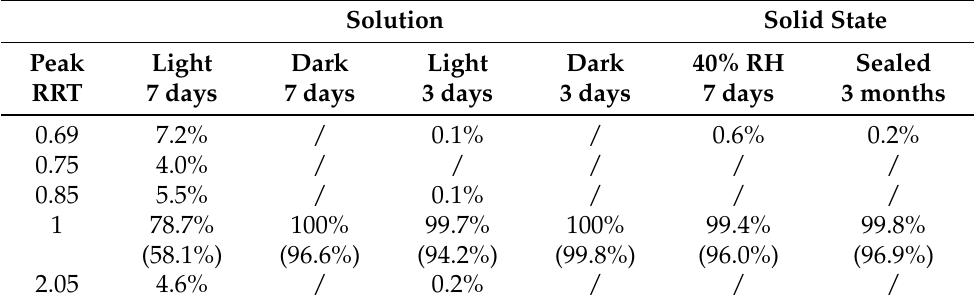
Table 1. HPLC-UV analysis of zolpidem hemitartrate samples subjected to photolytic degradation. In its solid state, zolpidem was stored in either a hermetically sealed glass vial or at 40% RH. The % recovery can be found between